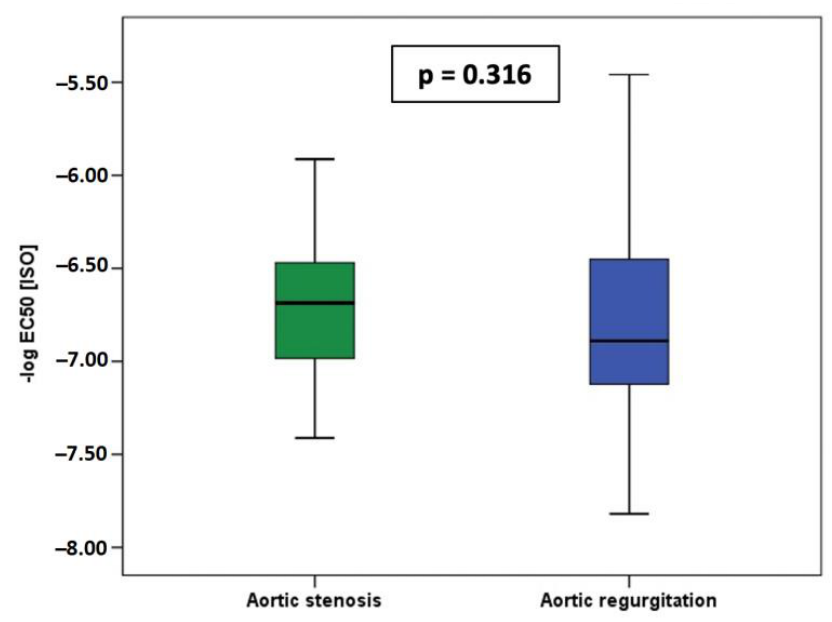
Figure 2. No significant differences of Beta-AR sensitivity ( − log EC 50 [ISO]) between patients with aortic stenosis (green) and regurgitation (blue).